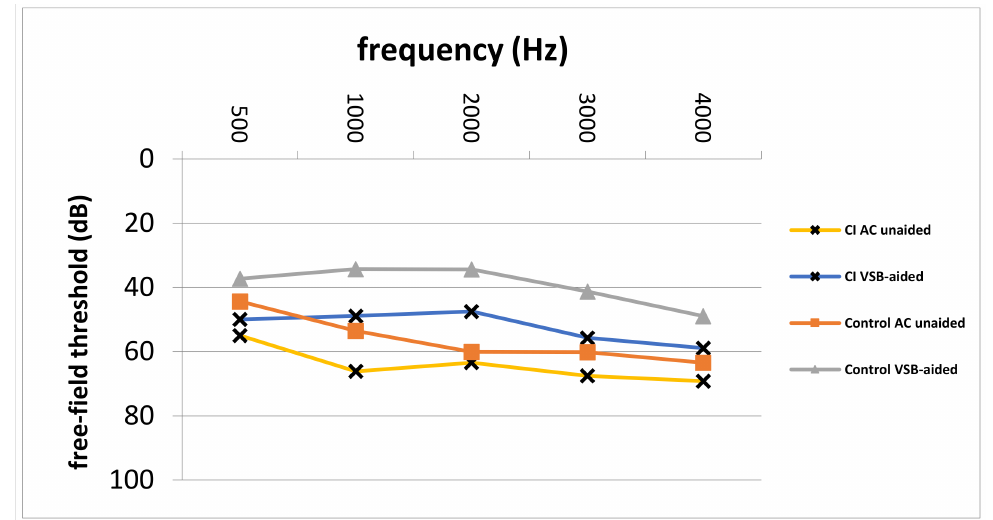
Figure 2. Postoperative unaided AC and VSB-aided thresholds in the CI and control group. CI, cochlear implant; AC, air-conduction; VSB, Vibrant Soundbridge; Hz, Hertz; dB, Decibel; Control, control group.